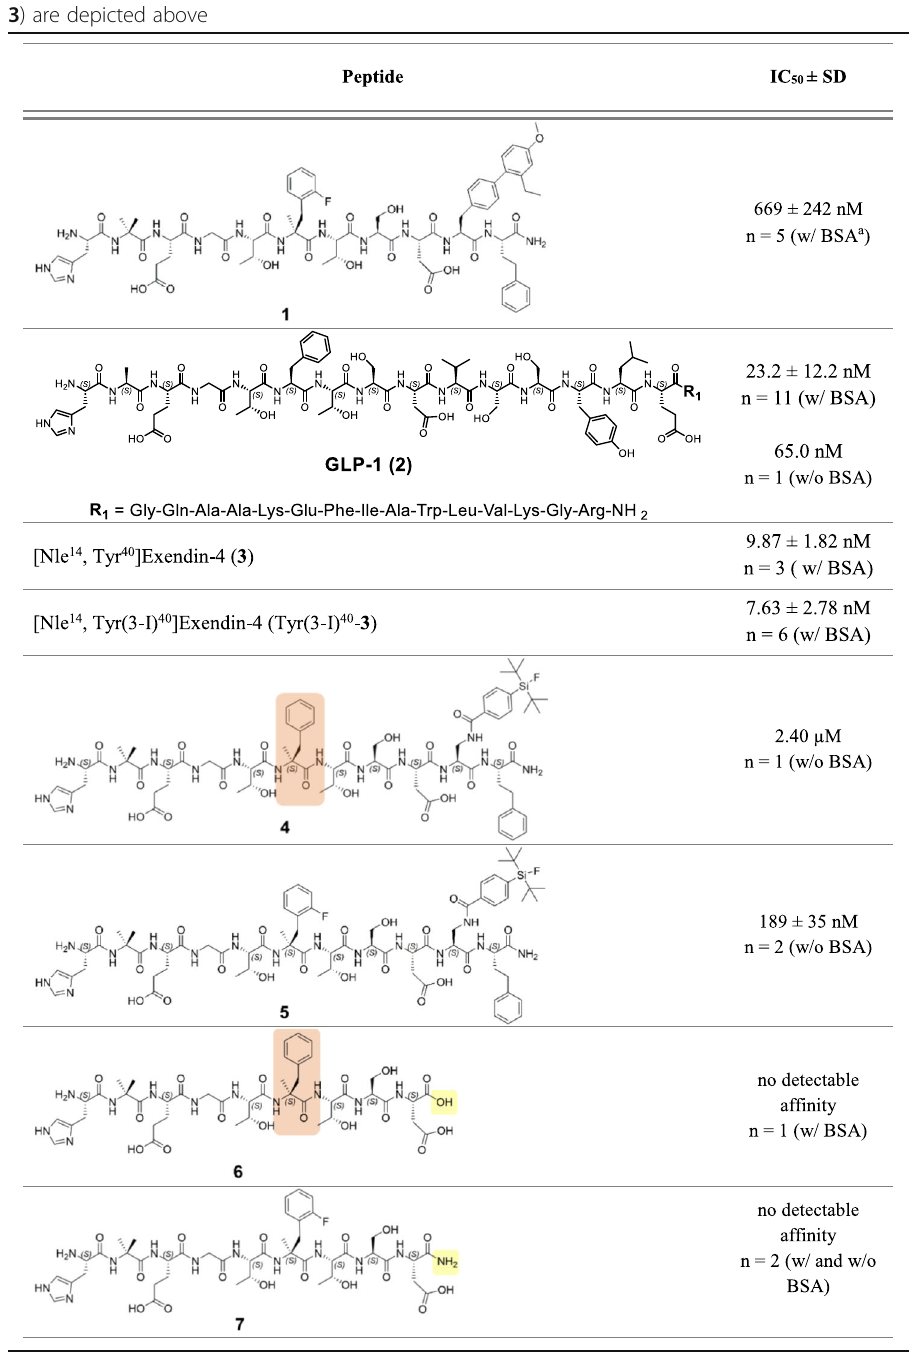
Table 1 IC 50 data of SiFA-tagged undecapeptides ( 4 and 5 ), peptides without C-terminal bulky substituents ( 6 , 7 and 8 ), SiFA-tagged chimeras of 1 and GLP-1 ( 9 to 13 ) as well as the C -terminal pentadecapeptide of GLP-1 ( 14 ) developed for targeting the GLP-1 receptor. IC 50 values